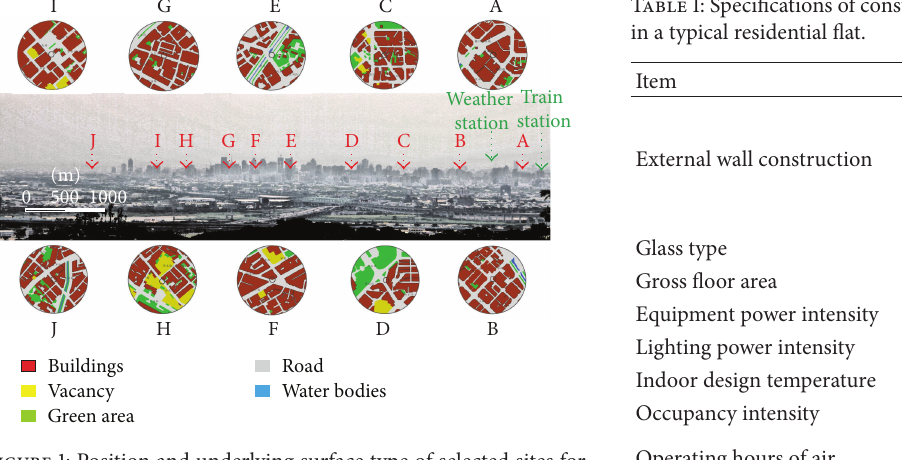
Figure 1: Position and underlying surface type of selected sites for field measurement.